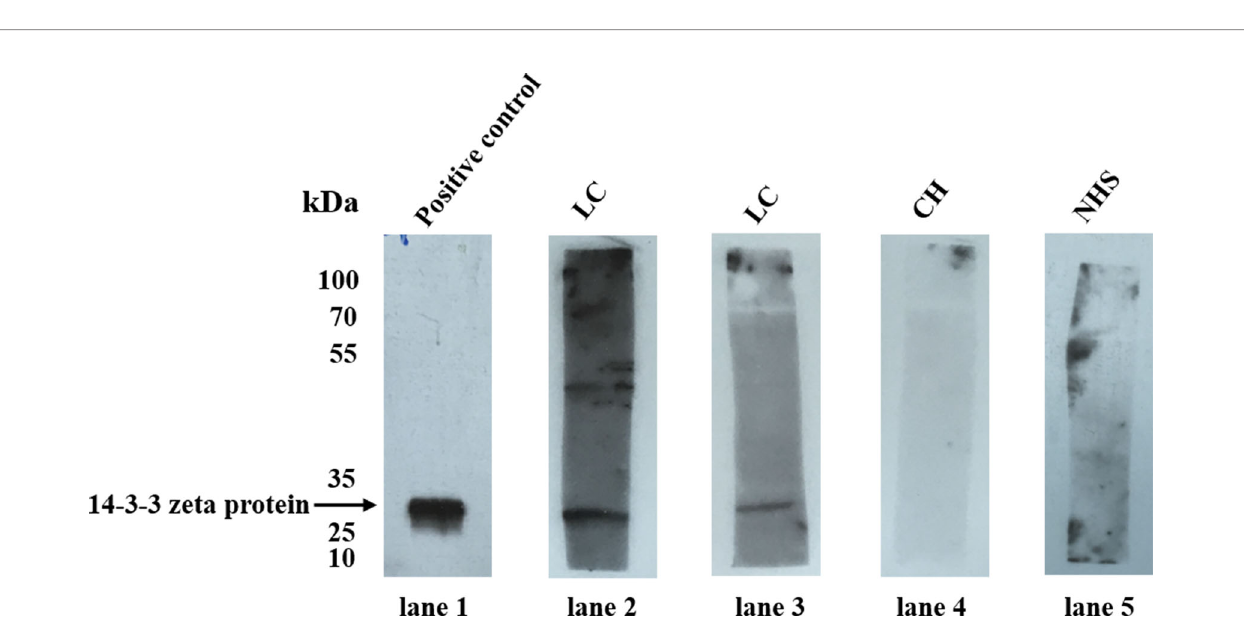
FIGURE 6 | Western blot analysis of representative sera assessed by ELISA. Lane 1, the polyclonal anti-14-3-3 zeta autoantibody was used as a positive control; lanes 2 and 3, two representative liver cirrhosis (LC) serum samples that were positive by ELISA also showed strong reactivity with 14-3-3 zeta recombinant protein by Western blot analysis; lanes 4 and 5, randomly selected chronic hepatitis (CH) sera and normal human serum (NHS) samples, respectively, with negative reactivity to 14-3-3 zeta recombinant protein.